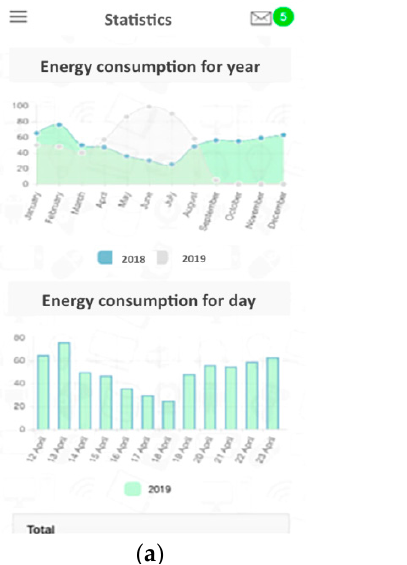
Figure 5. Interfaces of HEMS-IoT: ( a ) Statistics, ( b ) IoT services.